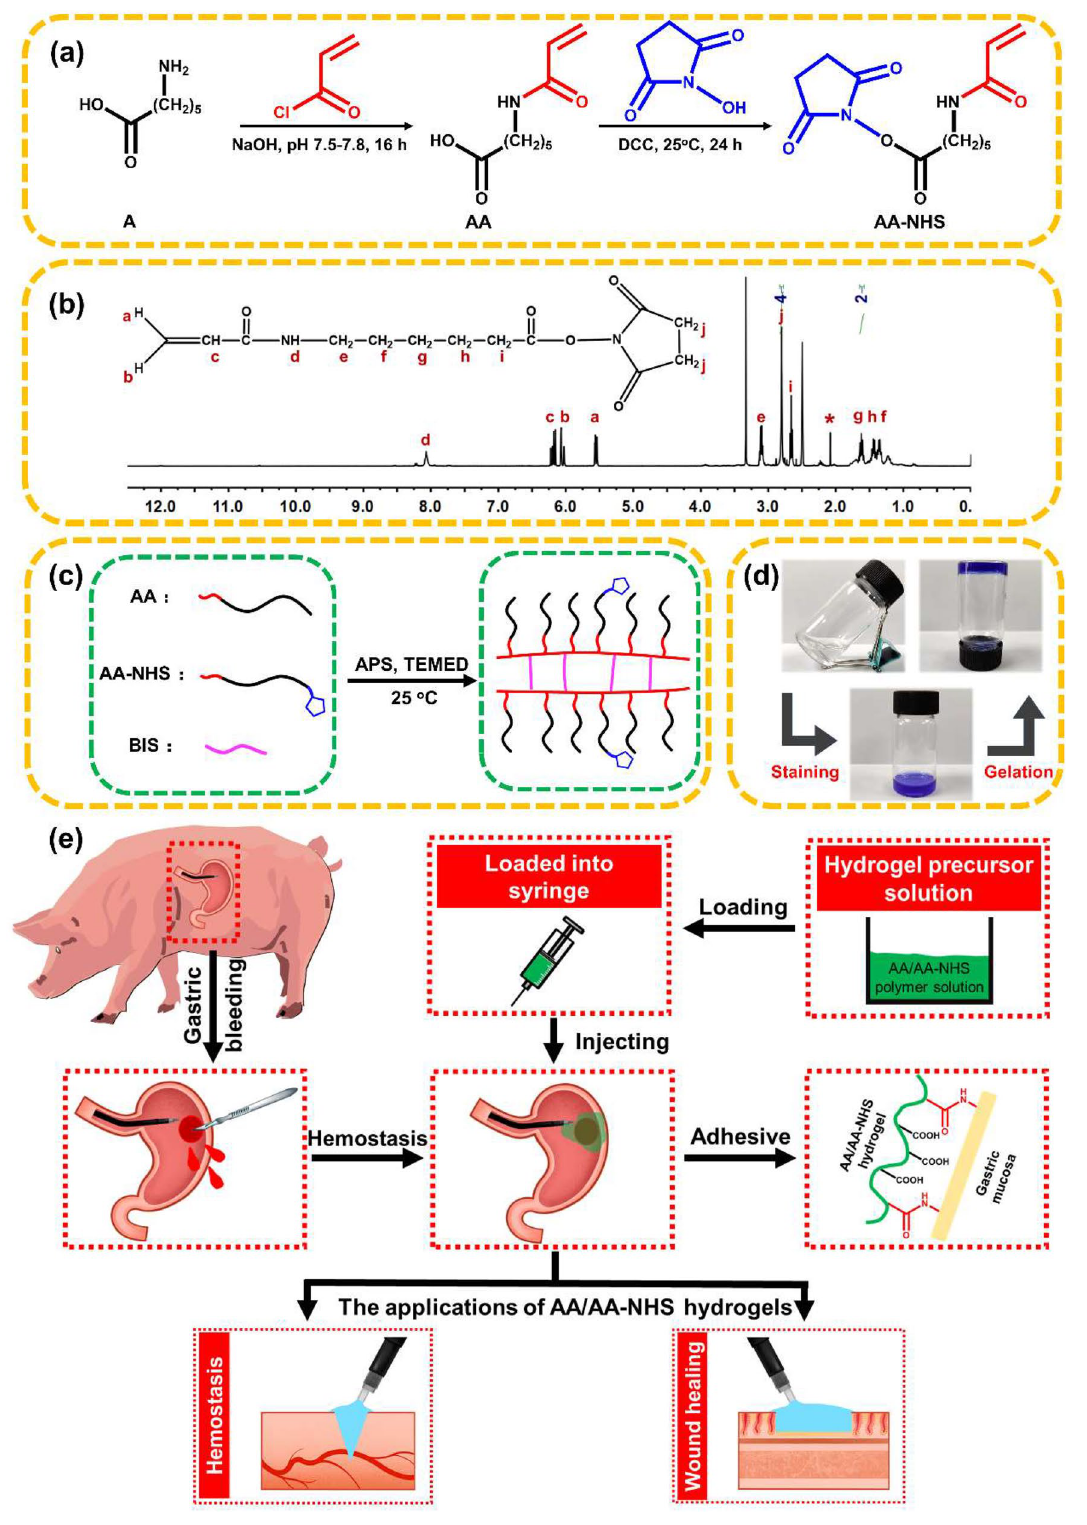
Fig. 1 Schematic representation of AA/AA-NHS hydrogel synthesis. a Synthesis of AA and AA-NHS ester copolymers. b 1 H NMR spectrum of AA-NHS. c Preparation and network of the AA/AA-NHS hydrogel. d Photographs of the AA/AA-NHS hydrogel polymer solution before and after crosslinking. The solution was stained with crystal violet. e The applications of AA/AA-NHS hydrogels for hemostasis and wound